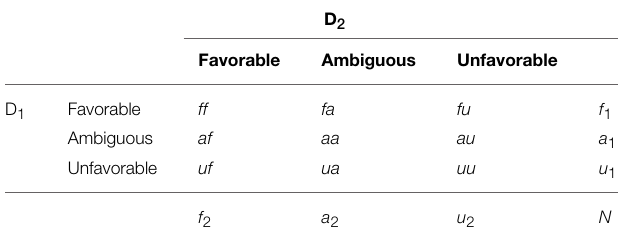
TABLE 3 | Favorable and unfavorable counts in the experienced-information setup. Favorable Unfavorable